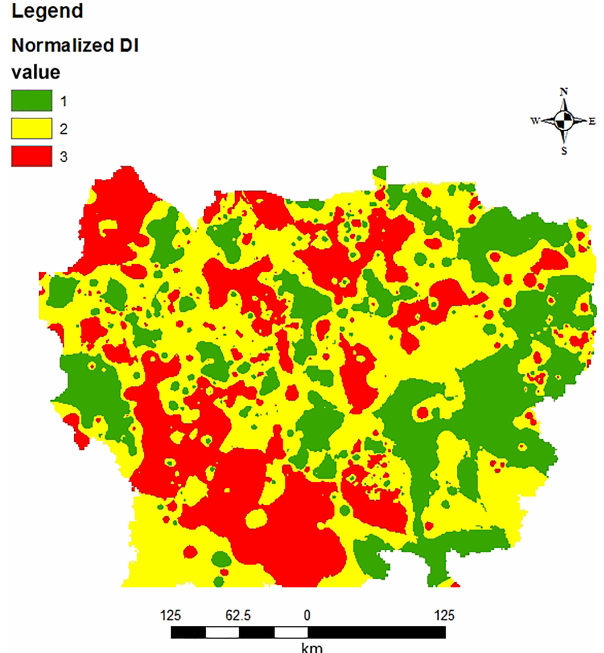
Figure 12. Normalized vulnerability